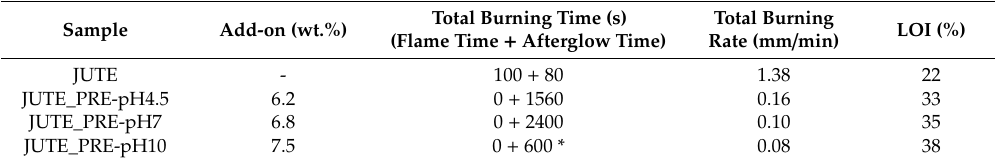
Table 23. Vertical flame spread data for jute fabrics before and after treatment with pomegranate rind extract solutions at di ff erent pH